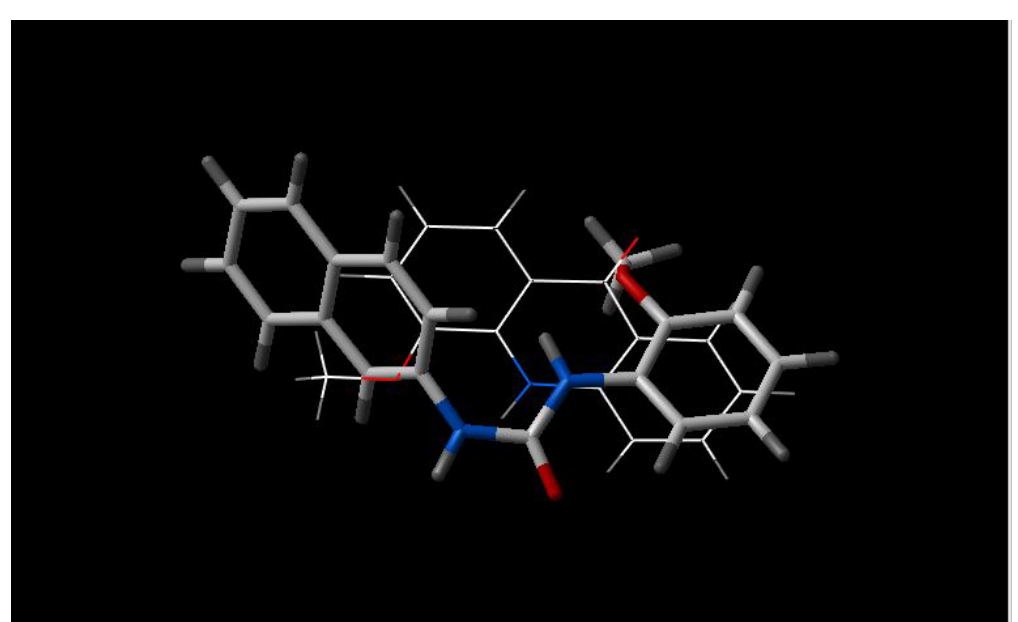
Figure 5. Best fit of optimised INF 271 (sticks) and GG918 A (wireframe)